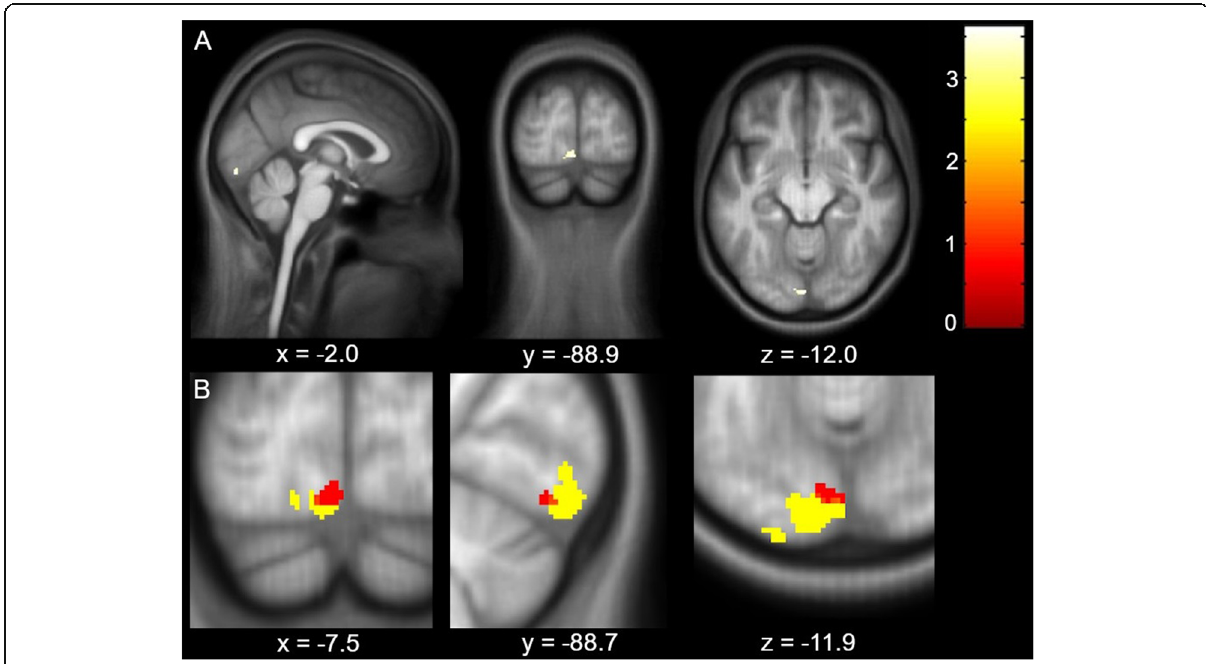
Fig. 3 Significant quadratic differences between verum and sham tDCS group revealed by TBM. Overlay of statistical parametric maps (uncorrected p < 0.001) shows a significant quadratic difference in the left lingual gyrus ( A ). The color bar indicates the t-score. Comparison of the statistical parametric maps (uncorrected p < 0.005, for illustrative purposes) of the cross-sectional cluster (in yellow) and the longitudinal cluster (in red) reveals that the regions of both clusters in the left lingual gyrus overlap ( B